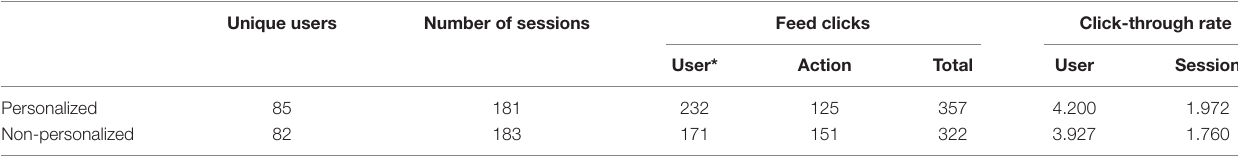
TaBle 3 | Feed uptake statistics.